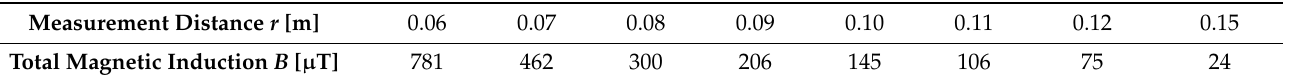
Table 2. Average values of the total vector determined on the basis of measurements for the angle of rotation α = 27°.